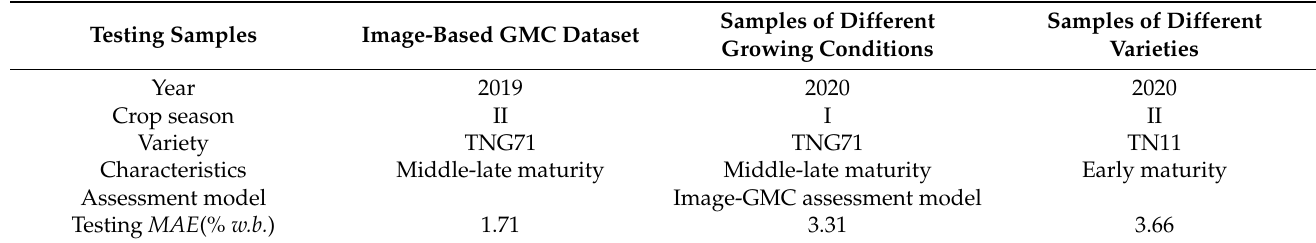
Table 6. Extended testing result.